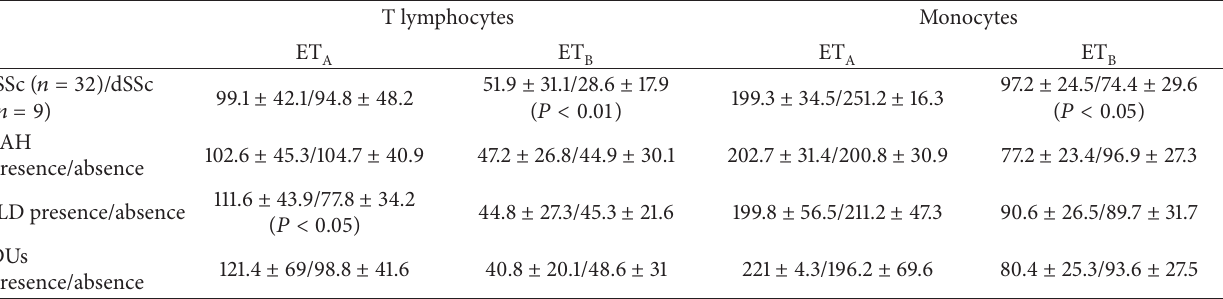
and ET expression on T lymphocytes and monocytes in relation to the clinical features of the disease, such as cutaneous form Table 2: ET A B and presence or absence of PAH, ILD, and